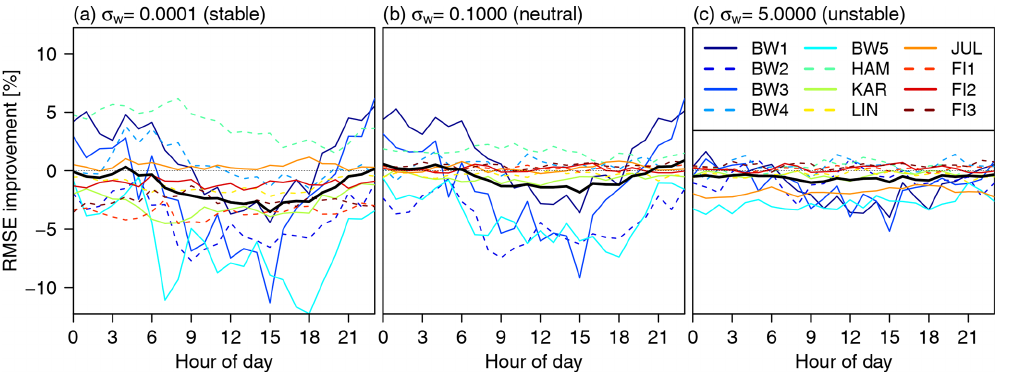
Figure 3. Diurnal cycle of the improvement in RMSE (PI w ) of the diagnostic wind model for (a) stable configuration ( σ w = 0 . 0001), (b) neutral configuration ( σ w = 0 . 1000) and (c) unstable configuration ( σ w = 5 . 0000) against COSMO-REA6. Positive (negative) values indicate better (worse) performance in terms of RMSE of the diagnostic wind